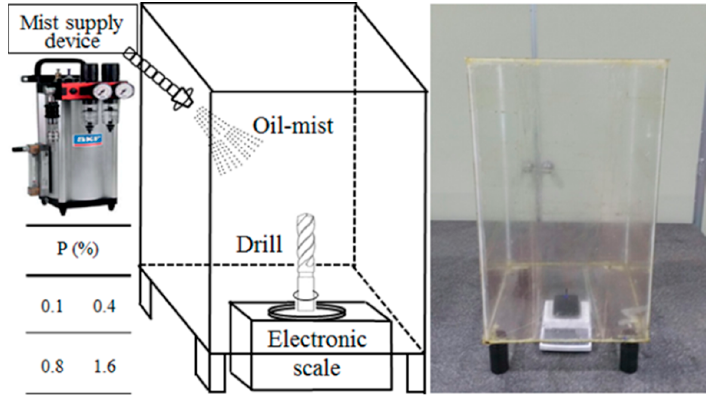
Figure 4. Experimental setup for adhesion test.